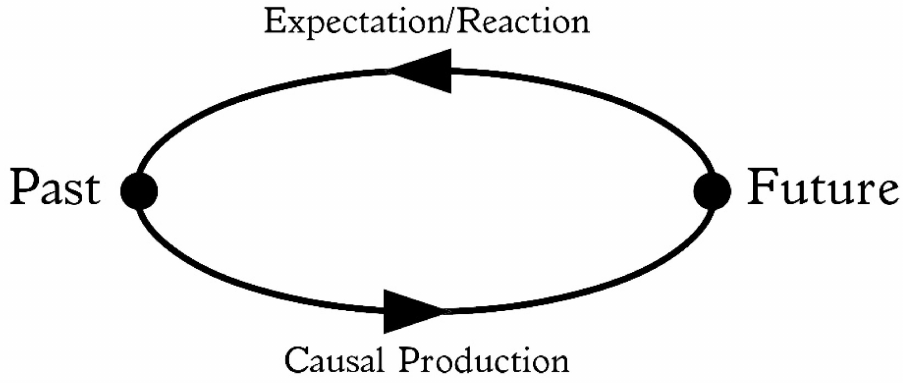
Figure 2. Dupuy’s diagram for the loop structure of projected time.